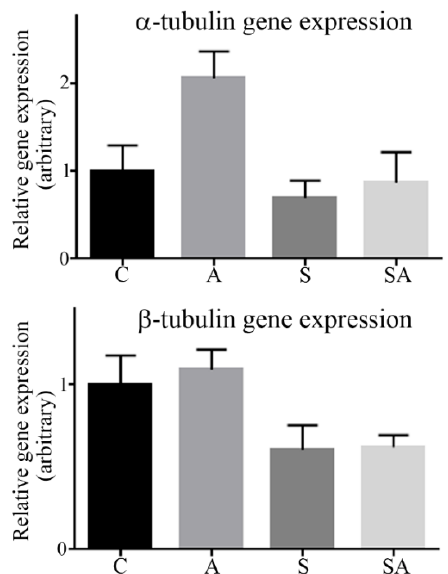
Figure 4. Quantitation of α - and β -tubulin gene expression by qRT-PCR. Relative gene expression of α -tubulin and β -tubulin in control (C), alcoholic (A), suicide (S), and suicide alcoholic (SA) patients was quantified using qRT-PCR. Expression of the genes beta actin, beta-2-microglobulin, and tyrosine 3-monooxygenase/tryptophan 5-monooxygenase activation protein zeta were used as housekeeping genes. Histograms are representative of means ± SDs, n = 6. Control values were set at 1.